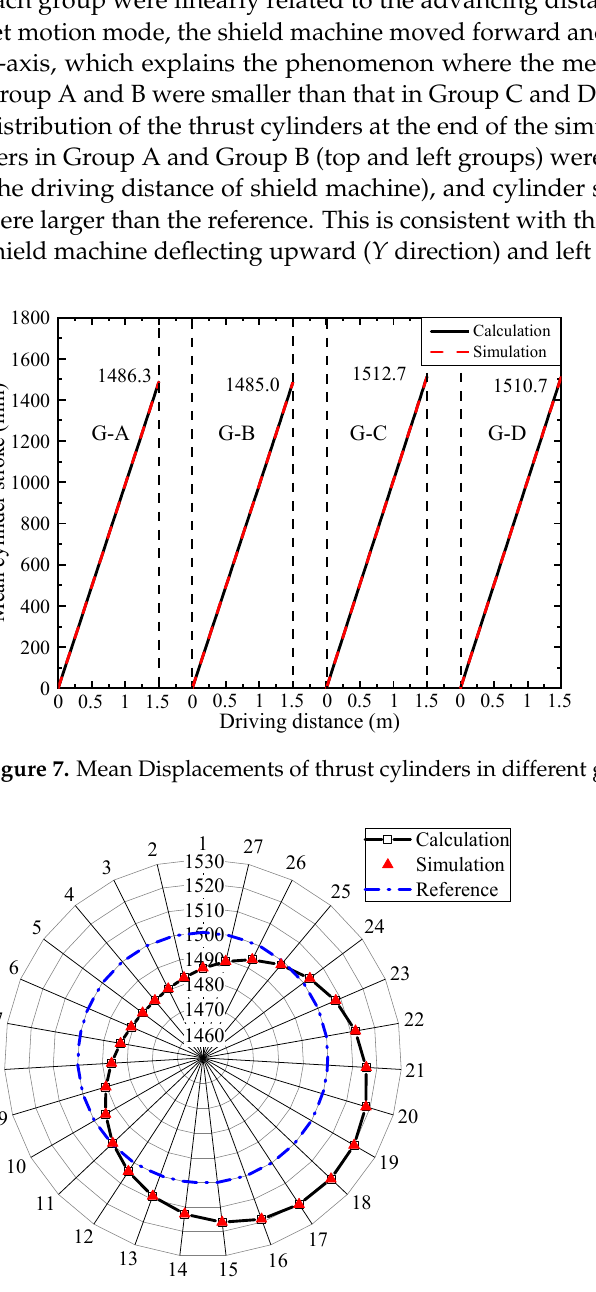
Figure 8. Displacement distribution of thrust cylinders at 50 s (unit: mm).